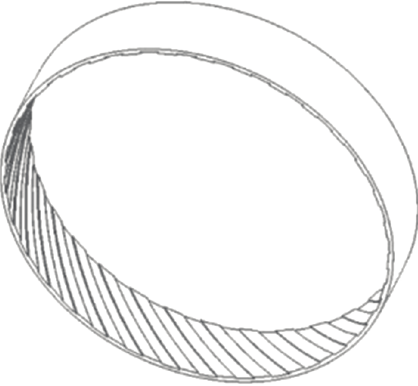
Figure 1: Helically grooved